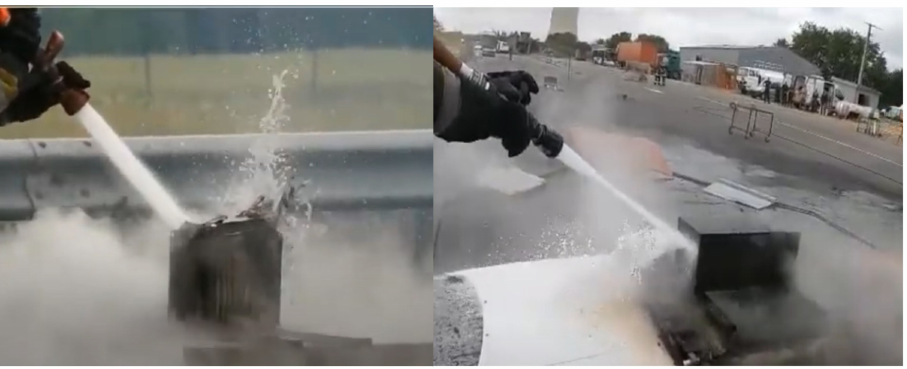
Figure 19. Exp. A.5 experiment. In the Exp. A.6 an LTO (Prismatic) LIB pack was used. The base of this package was steel, and the periphery was covered with aluminum. Thermal runaway started to occur in the 2nd minute and 15th second from the start of heating. An intense fire was observed and also explosions with the deterioration of the prismatic cells after the thermal runaway. After the 4th minute of the beginning of heating, the water extinguishing activity was applied. The aluminum surrounding of the battery pack melted at some points and formed holes. These holes were effective in terms of extinguishing with water (Figure 20).